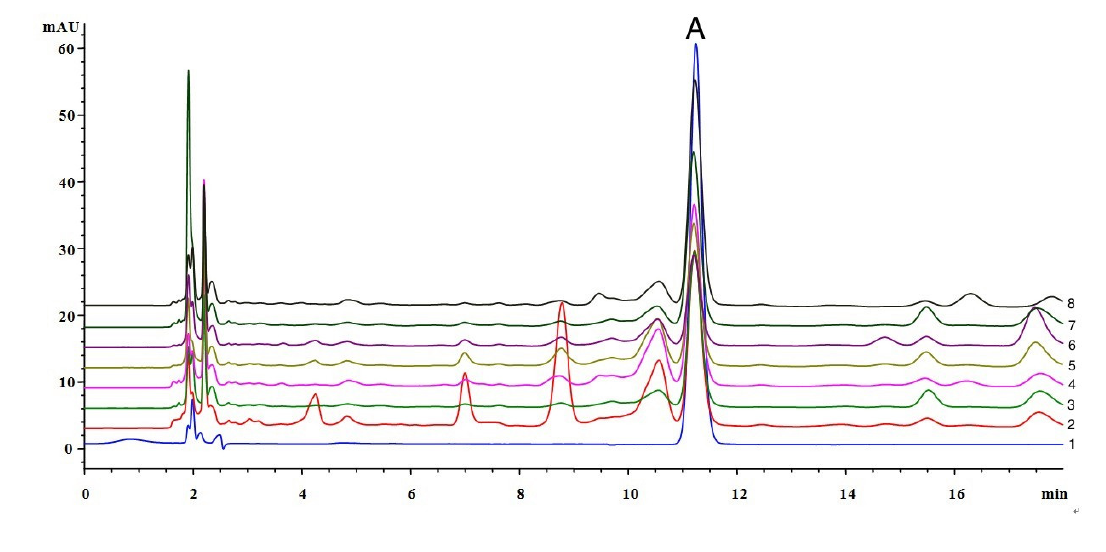
Figure 2. HPLC chromatogrsams of (1) catechol standard and (2–8) different poplar